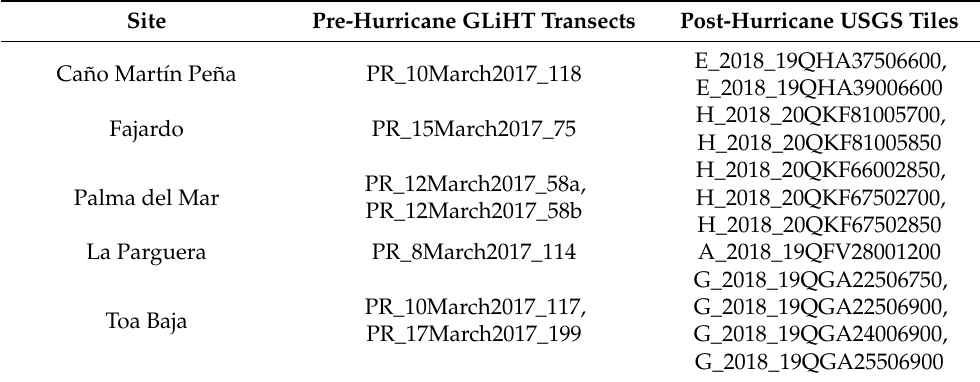
Figure 1. Puerto Rico geographical location ( up ) and location of five sites along its coast ( low ). Red and blue lines depict the paths of Hurricane Maria and Hurricane Irma, respectively. Table 1. Pre- and post-hurricane LiDAR point-cloud images provided by the NASA G-LiHT and the USGS 3D Elevation